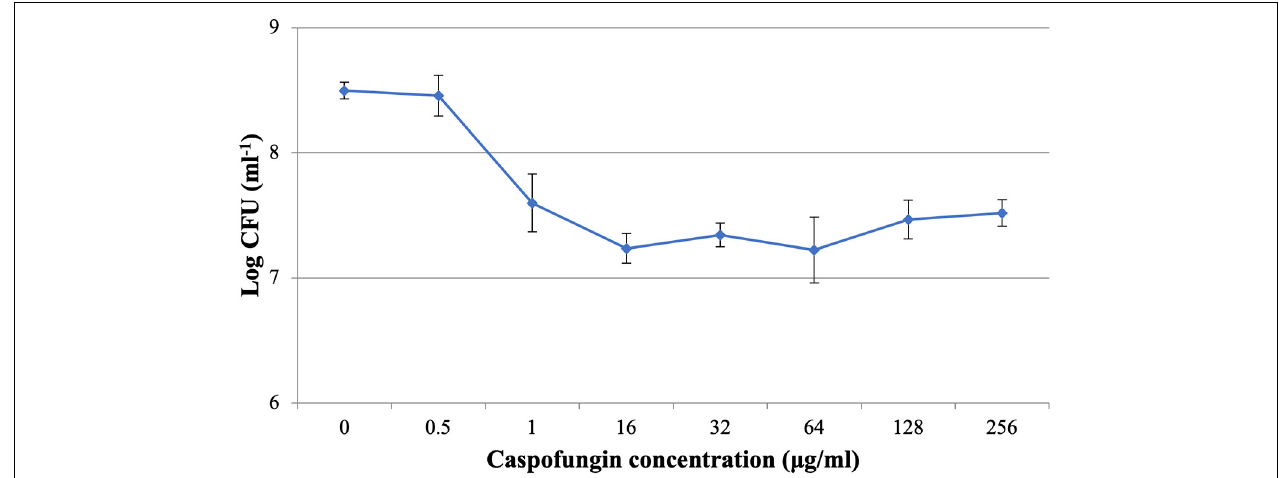
FIGURE 1 | Caspofungin-induced inhibition of C. albicans biofilms for 24 h. The increase of CAS concentration failed to eradicate the biofilms. Data represent means ± SD of three biological replicates from one representative experiment out of two independent ones with similar results.